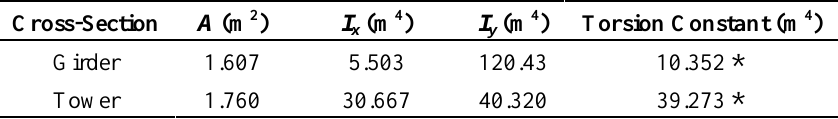
Table 3. Cross-sectional